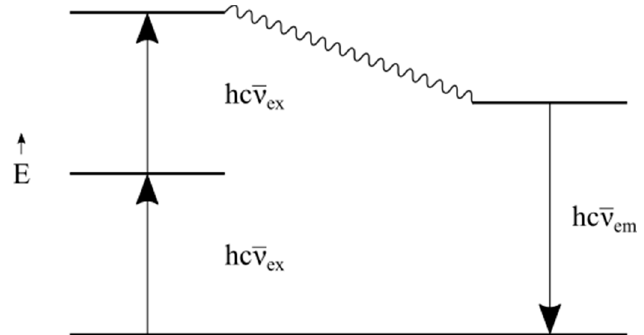
Figure 21. Schematic of two-photon luminescence upconversion spectroscopy. Two low-energy excitation photons hc ν ex penetrate to the desired tissue depth owing to the minimization of Rayleigh scattering and tissue absorption. These photons then combine to yield a single high-energy emission photon hc ν em that can be used as a laser scalpel to destroy a tumor or an individual